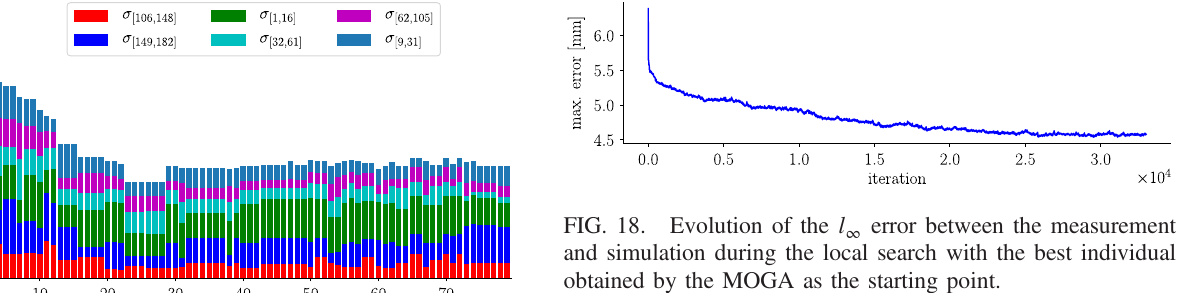
TABLE I. Result of the best individual obtained by optimiza- tion using the l ∞ -error norm for each objective. The label σ ½ indicates an objective for the turns in the range ½ l; u (cid:2) . Objective σ ½ l;u (cid:2)